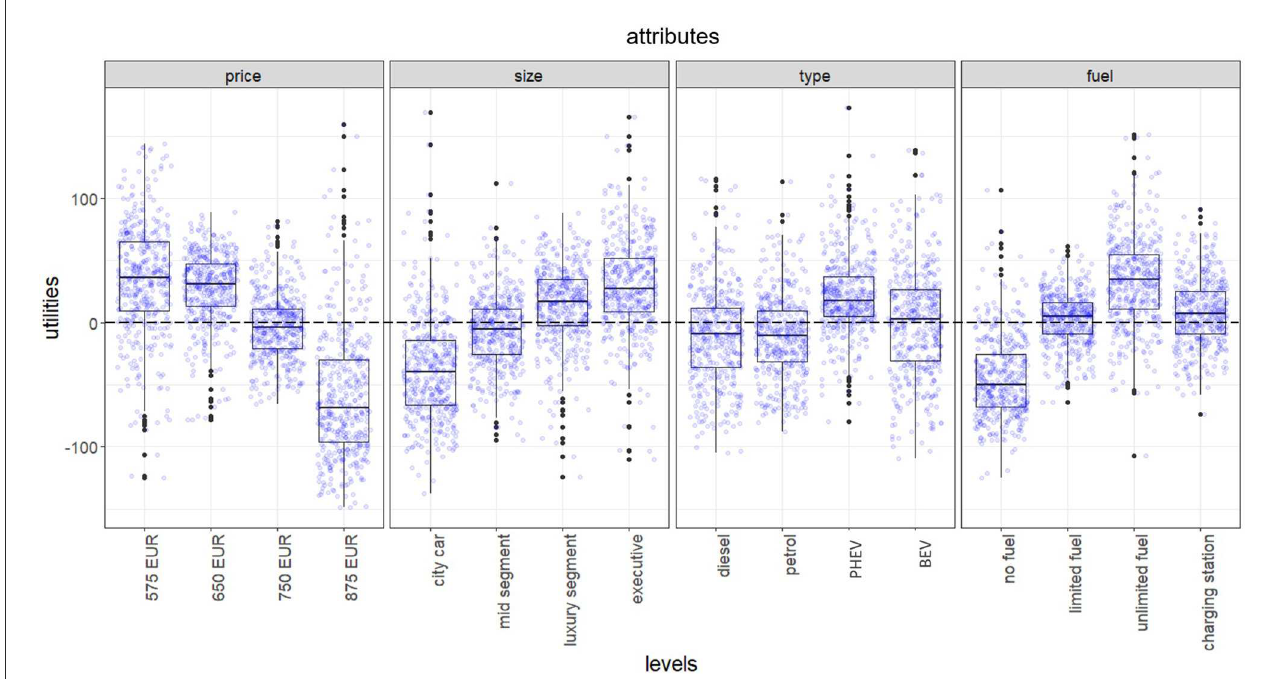
FIGURE2 Visual representation of zero-centered utilities for each attribute level (price, segment, engine type, and fuel card) of the company car.